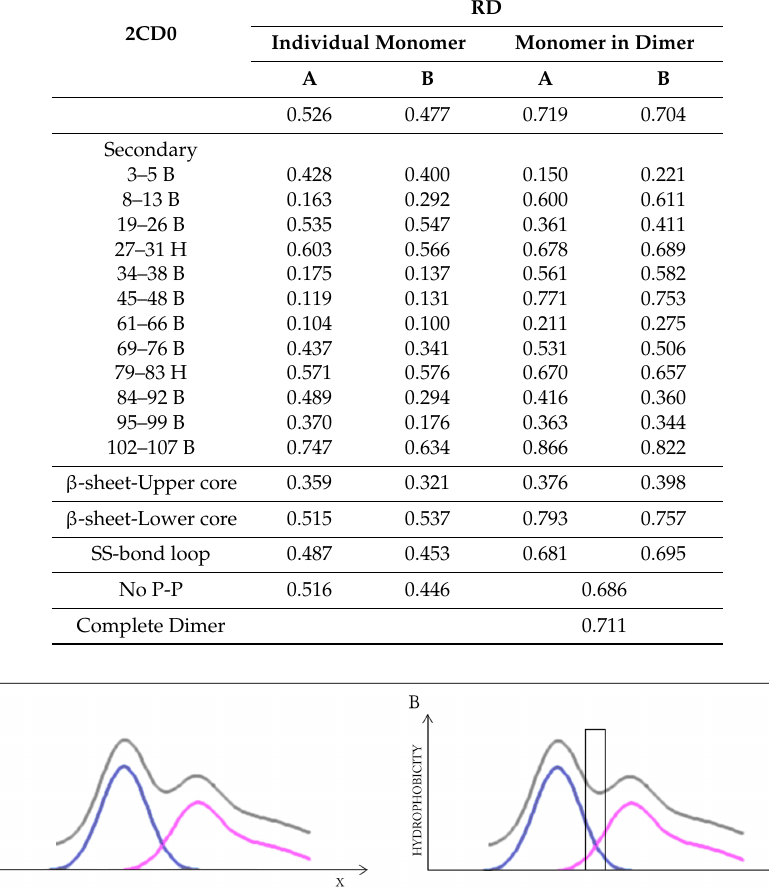
Table 5. RD coefficients describing the status of the hydrophobic core in the dimer and in each monomer of 2CD0. The table also lists the status (with respect to the monomer and the dimer) of individual folds: helixes (H), β -folds (B), upper core, lower core fragments bounded by Cys residues forming SS bonds, as well as fragments following elimination of residues involved in protein-protein interaction.